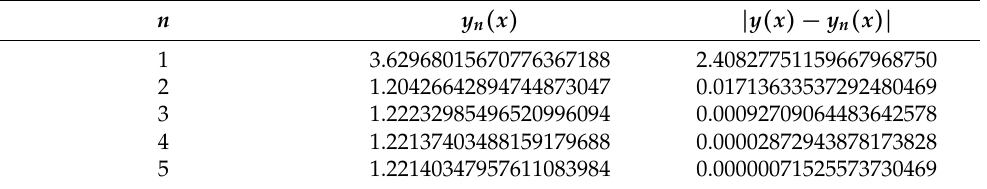
Figure 1. ( a ) Comparison between the solutions—( b ) error of Example 1 for n = 10. Table 1. Applying the FPA for Example 1 with (cid:101) = 10 − 5 and x = 0.2.